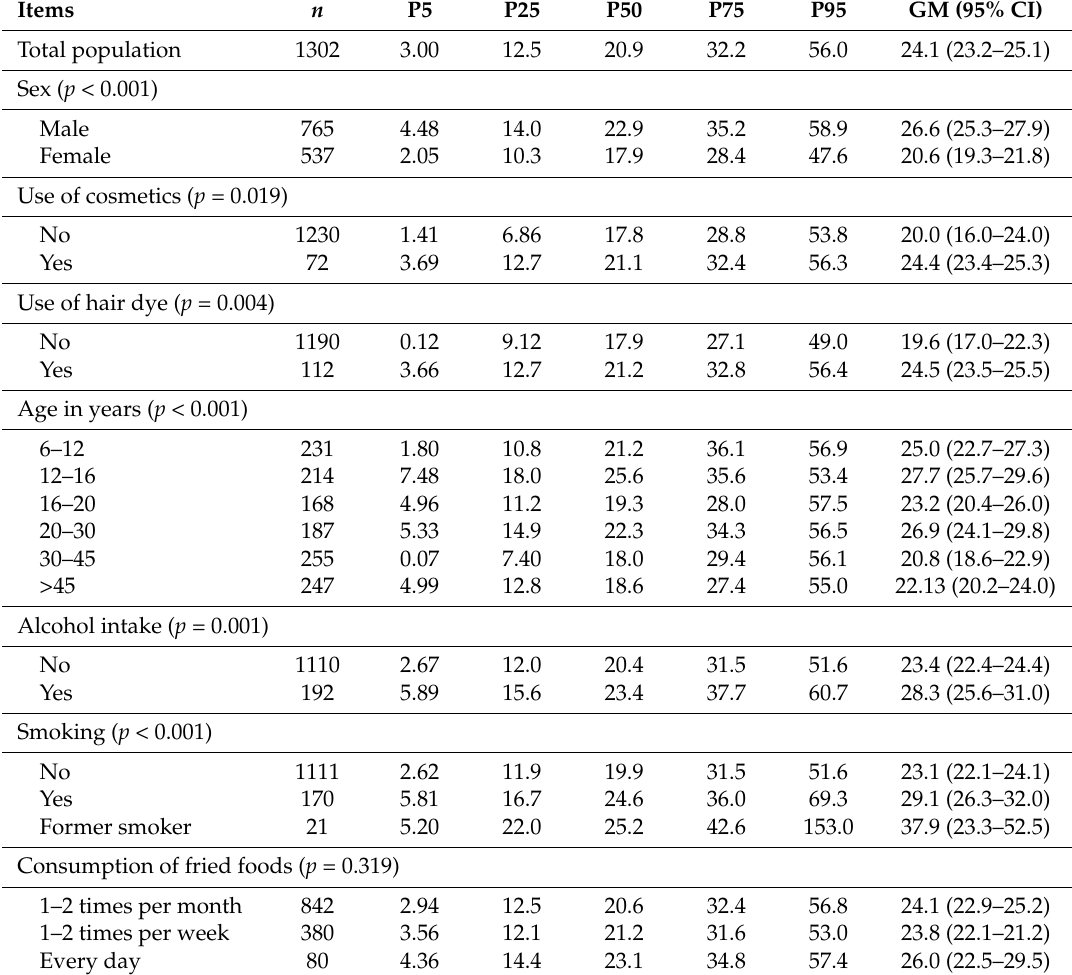
Table 3. Blood 208 Pb levels ( µ g/L), stratified by relevant categorical